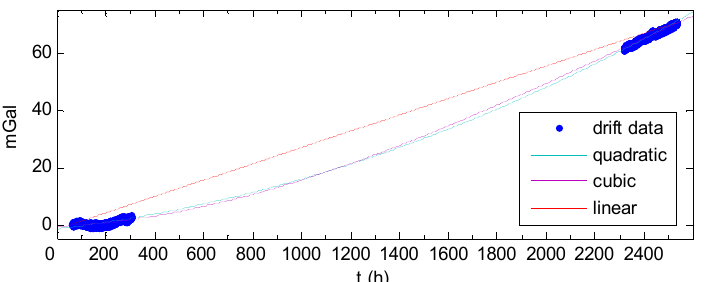
Figure 9. Curve fitting using the static data.